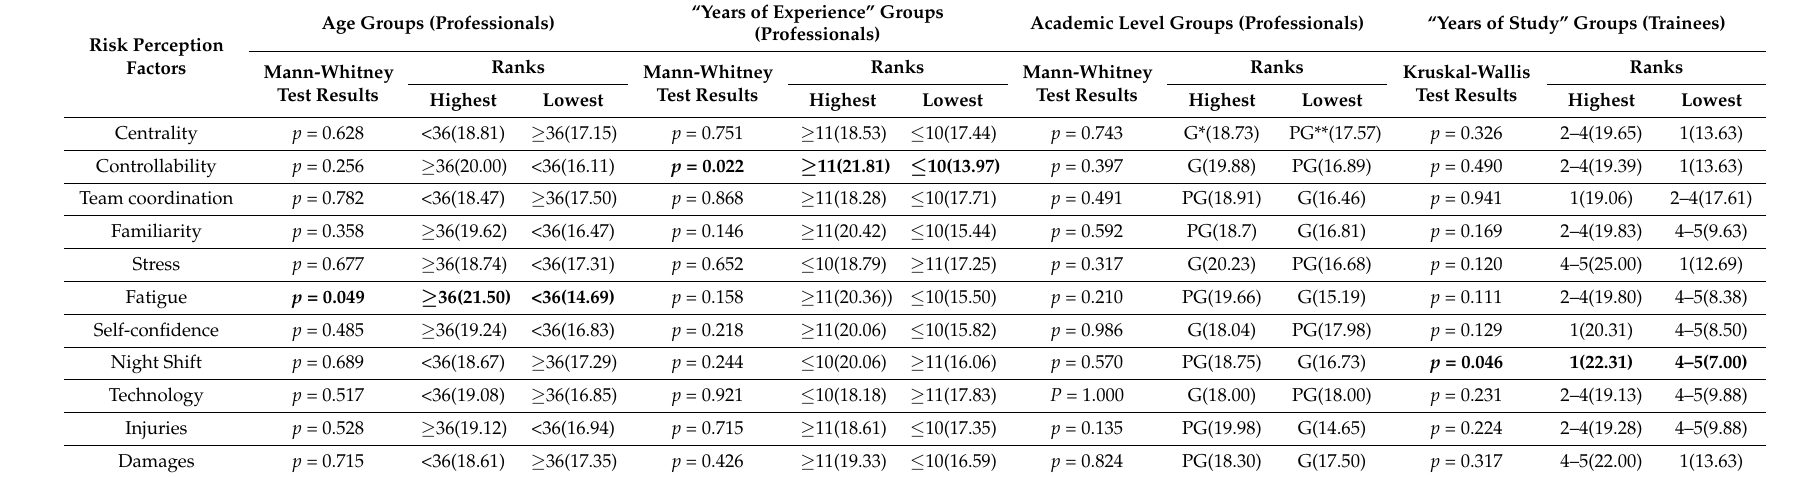
Table A3. Within groups differences—risk perception factors (significant results in bold).